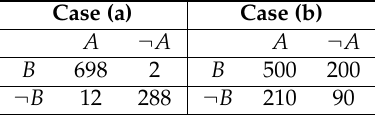
Table A1. The number of examples with the given results. X corresponds to an example where system X gave the correct answer, and ¬ X —to an example where it gave an incorrect